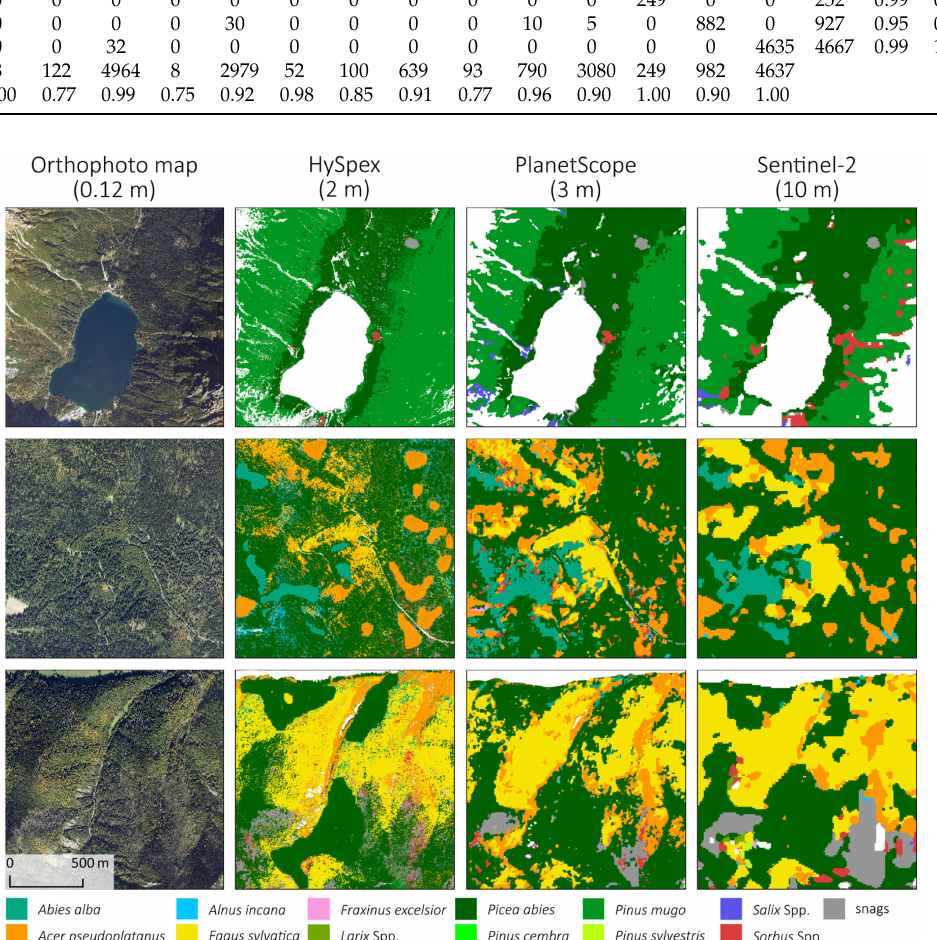
Figure 12. Comparison of obtained classification maps based on HySpex hyperspectral images, PlanetScope, and Sentinel-2 data, with topographic features (digital elevation model, canopy height model, and slope and aspect